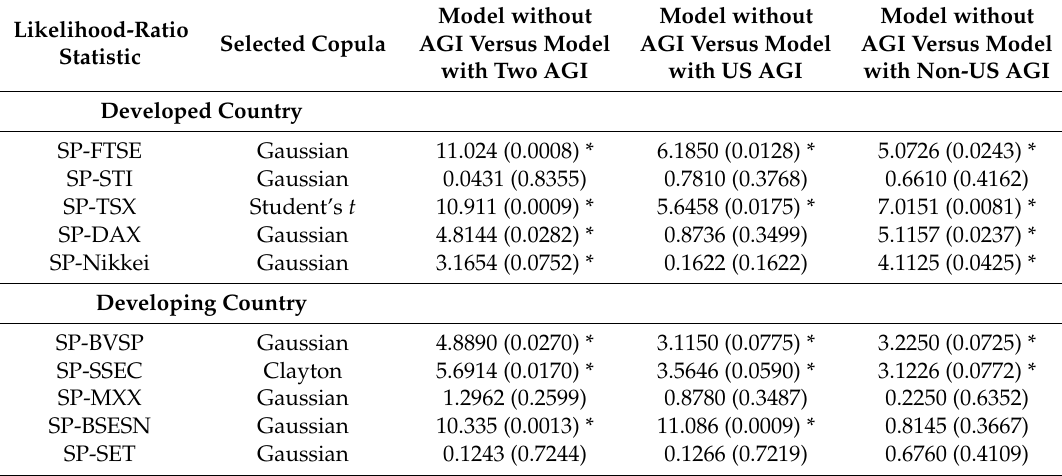
Table 8. The selected dynamic copulas and LR-test